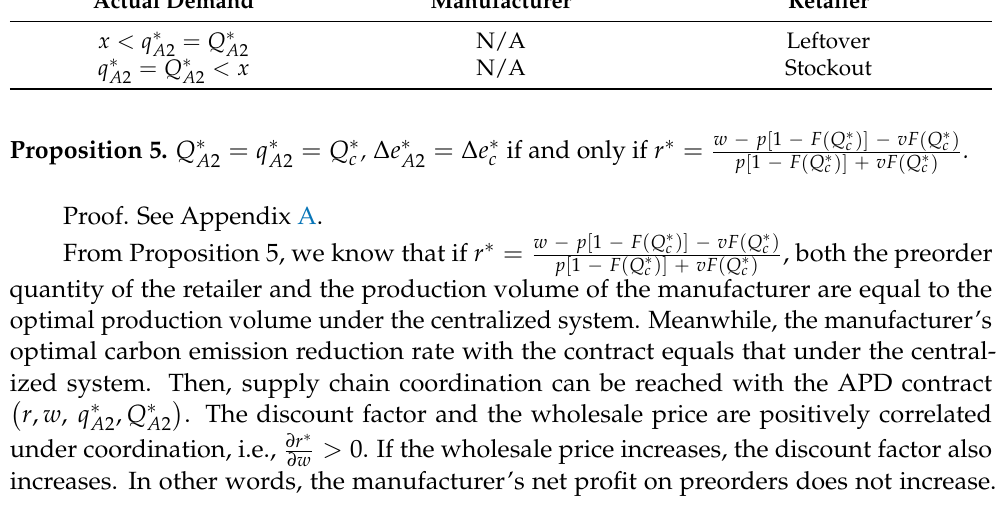
Table 3. Risk-sharing of partners under the APD contract